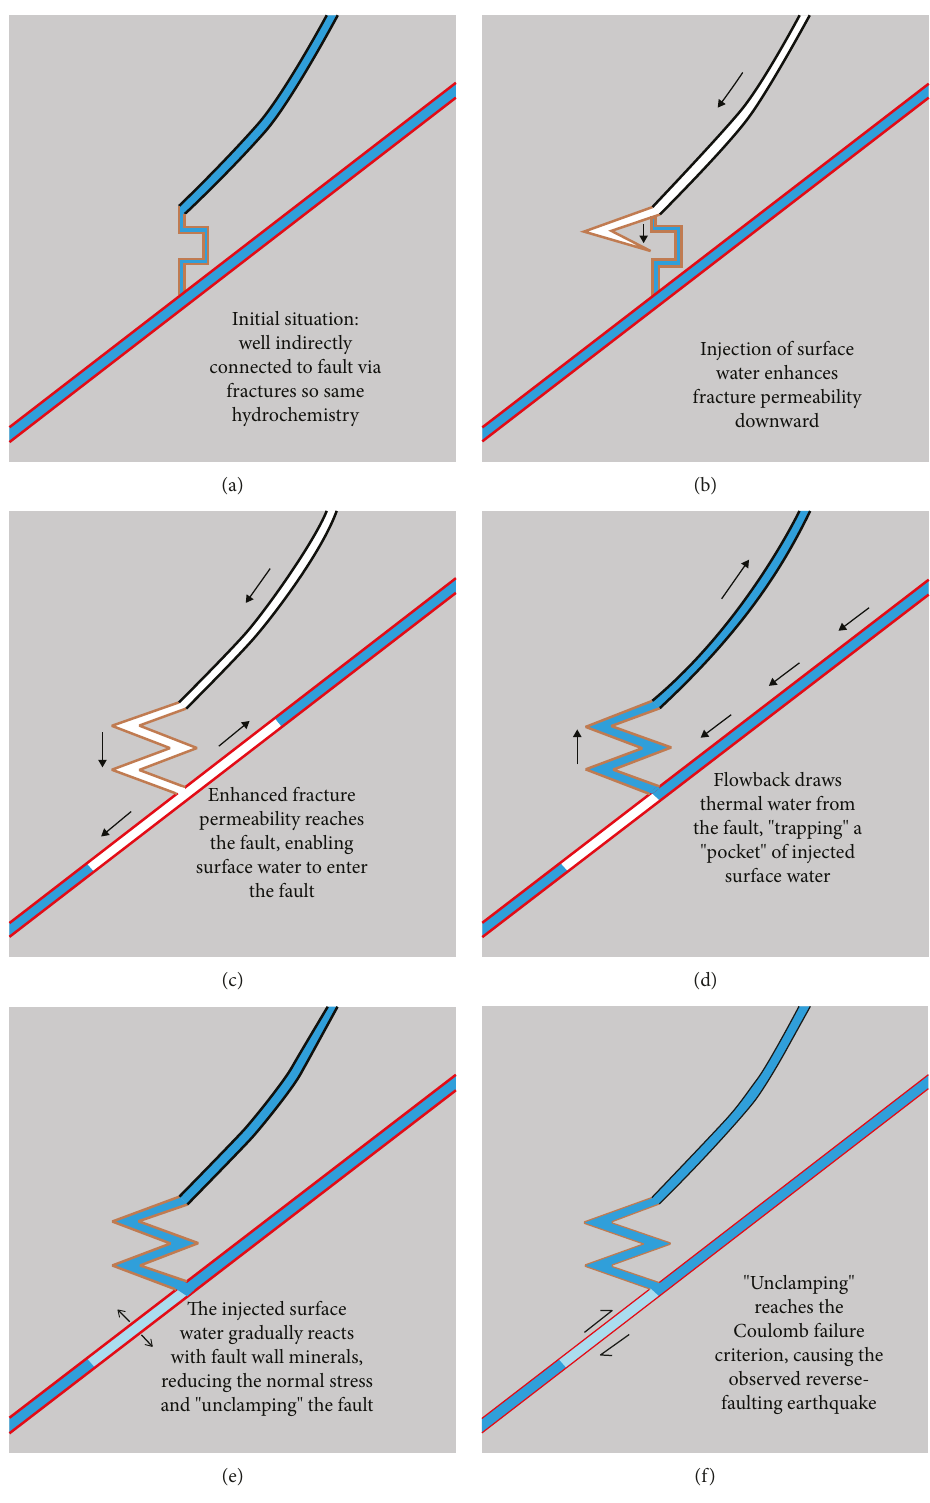
Figure 11: Conceptual model linking injection into well PX-1 to the 15 November 2017 earthquake. Panels depict NW-SE cross-sections across the Namsong Fault (cf. Figure 2(b)), not to scale. The “ zig-zag ” pattern of fracturing re fl ects the analysis indicating a preferred orientation, given the local stress fi eld, at 30 ° dip towards S69 ° E or N69 ° W, or towards N83 ° E or S83 ° W, depending on the choice of model stress fi eld. Using standard theory, the largest earthquake in August 2017 ( M 1.9; [17]) would correspond to shearing of a fracture with W dimensions no greater than ~ 50 m, indicating the probable upper bound to the individual “ zig-zag ” fracture segments. See text for